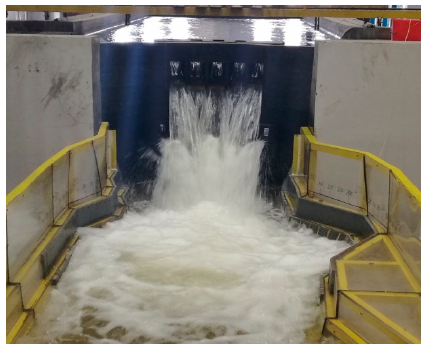
Figure 1. A photograph of the physical model test of the Wudongde arch dam.